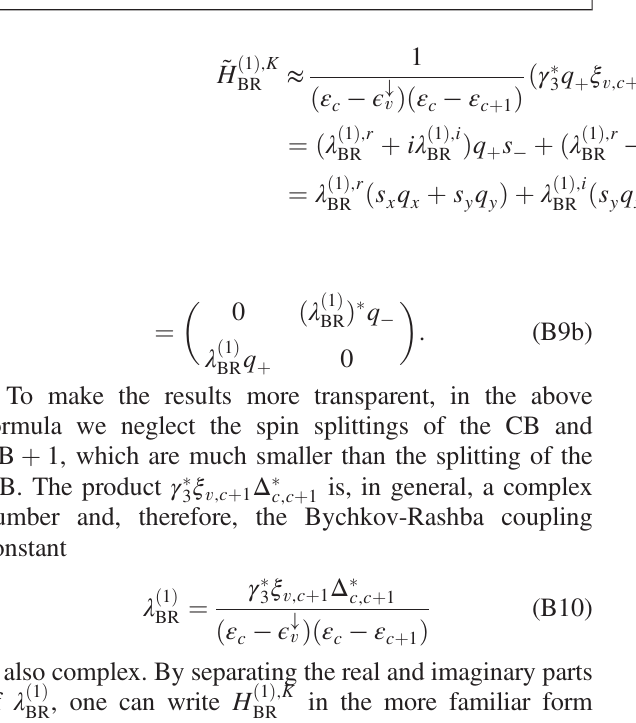
TABLE VIII. Band-edge shift H V =